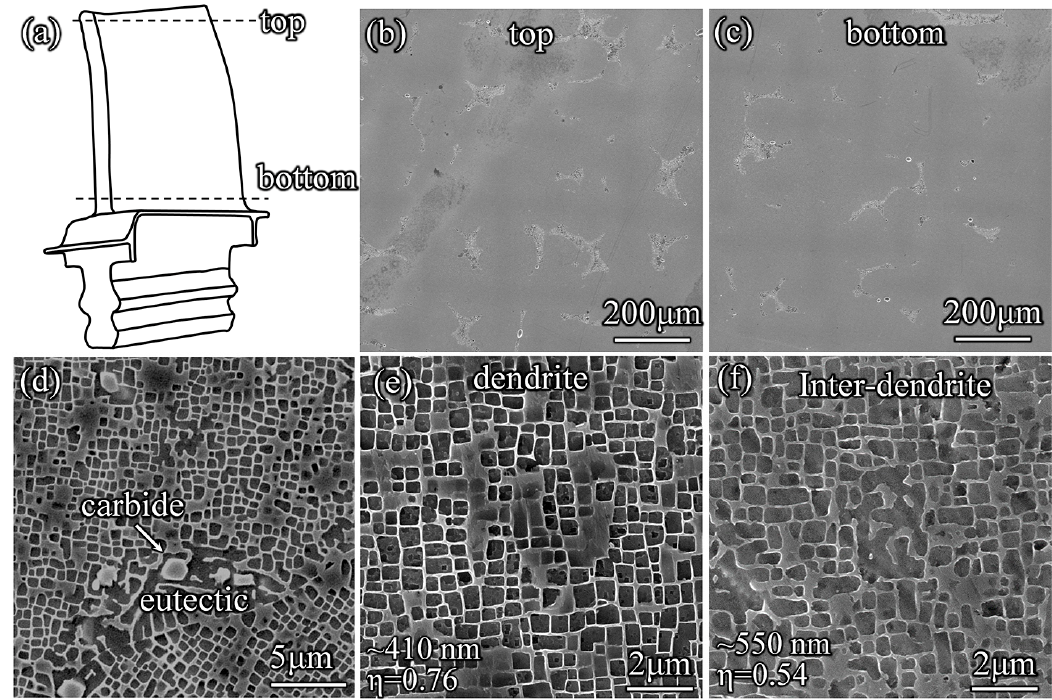
Figure 3. The microstructure of the blade. ( a ) Schematic diagram of the blade, indicating the cross- section position used for the experiment. ( b , c ) The blade’s top and bottom microstructure. ( d ) Inter- dendrite structure of blade containing eutectic and carbide. ( e , f ) Dendritic stem and inter-dendrite microstructure of the blade’s top microstructure, the γ′ phase size, and form factor are labeled.